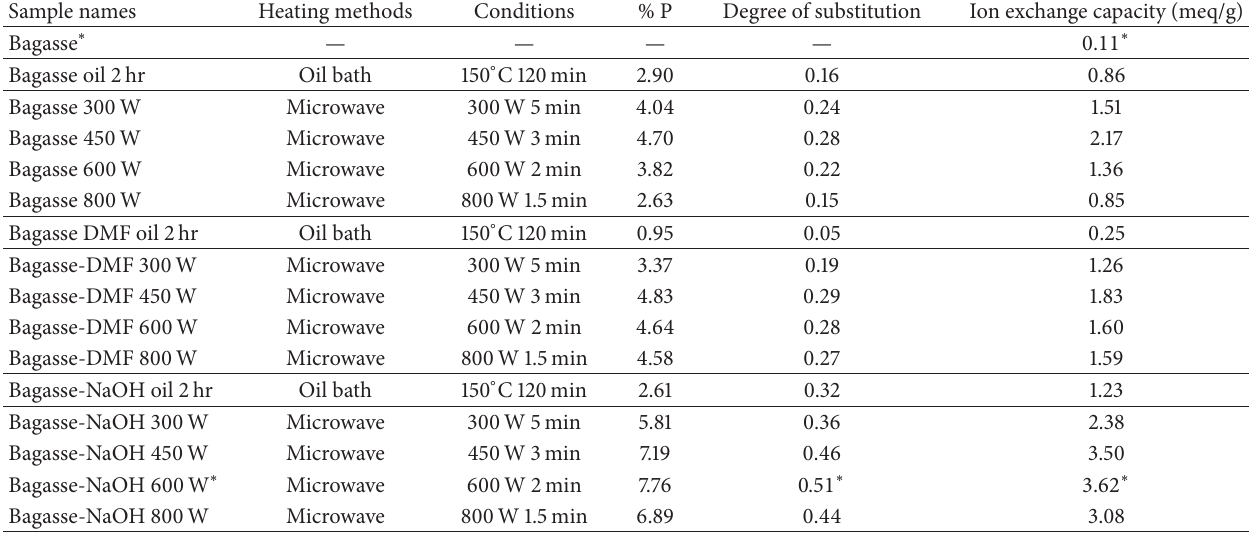
Table 3: Reaction conditions for preparations of modified rice straw, phosphorus content, degree of substitution, and ion exchange capacity of the modified rice